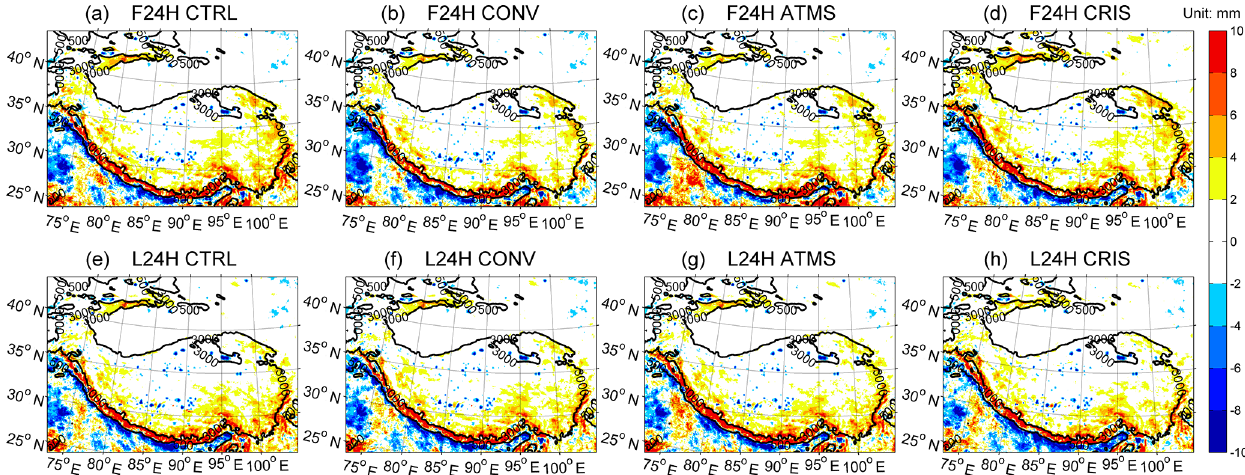
Figure 5. Difference value distribution of monthly mean precipitation (unit: mm) during July for data assimilation minus observation exper- iments. (a, e) CTRL minus OBS; (b, f) CONV minus OBS; (c, g) ATMS minus OBS; (d, h) CRIS minus OBS for (a–d) F24Hforecast and (e–h) L24Hforecast. Black contours are altitude (unit: